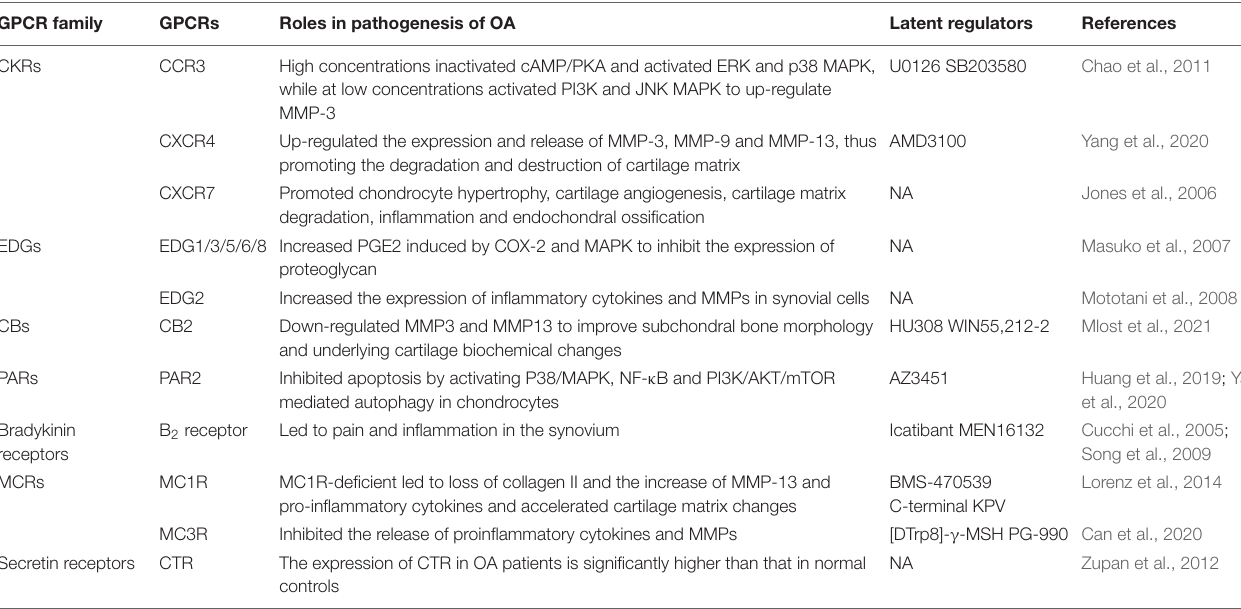
TABLE 1 | Novel roles of GPCRs in